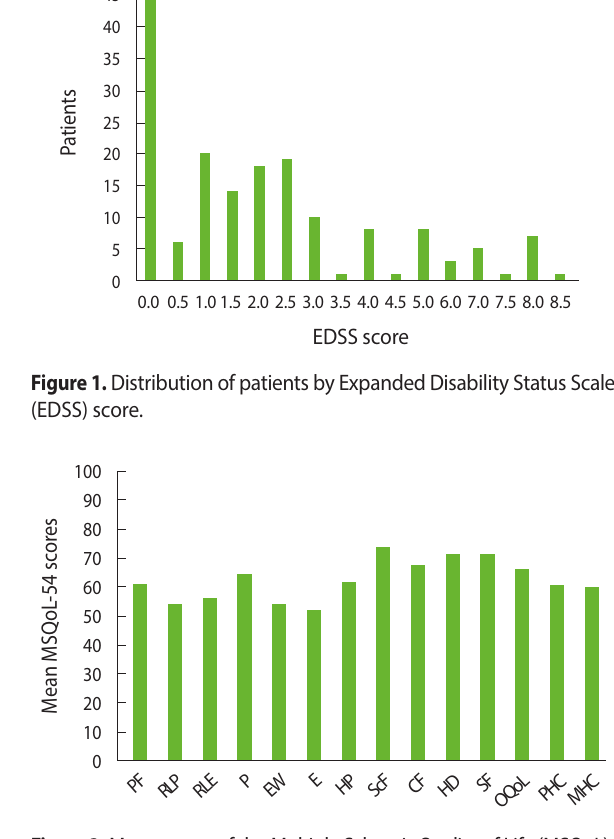
Figure 2. Mean scores of the Multiple Sclerosis Quality of Life (MSQoL)- 54 subscales. PF, physical function; RLP, role limitation-physical; RLE, role limitation-emotional; P, pain; EW, emotional well-being; E, ener gy; HP, health perception; ScF, social function; CF, cognitive function; HD, health distress; SF, sexual function; OQoL, overall quality of life; PHC, physical health composite; MHC, mental health